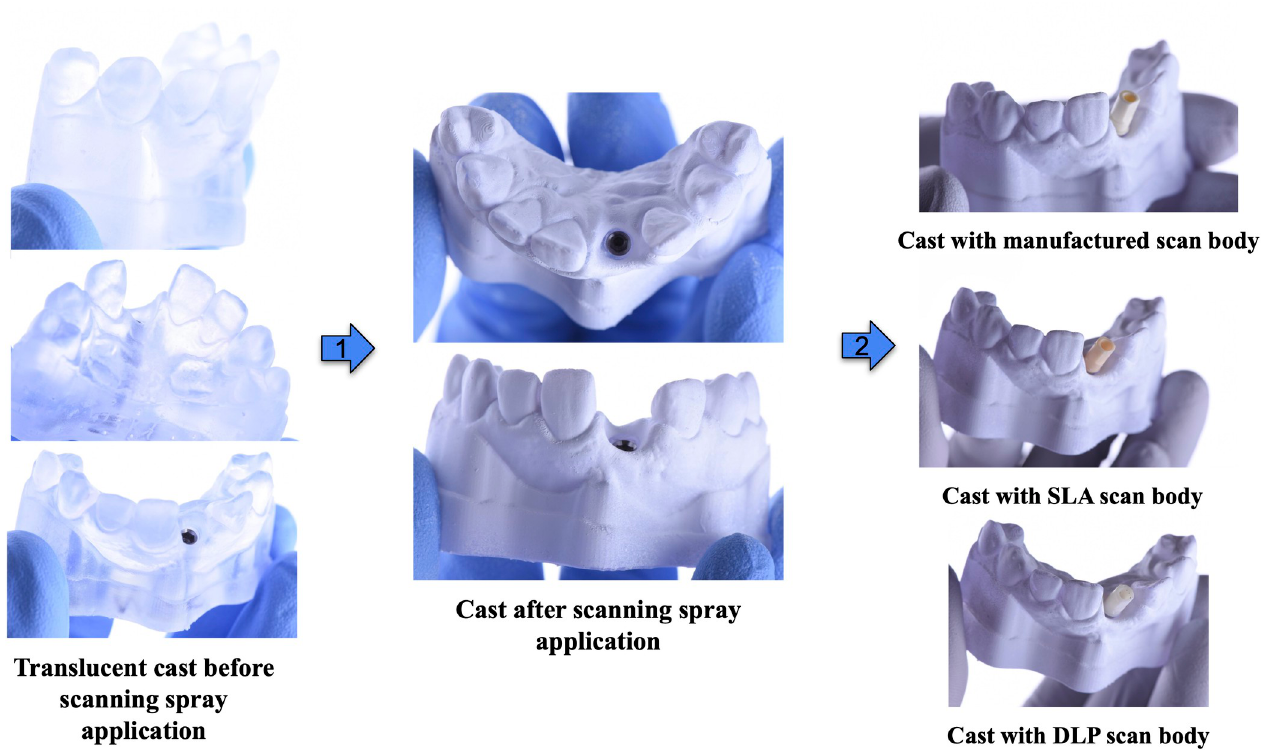
Fig 3. Simulated dental cast with implants and scan bodies in